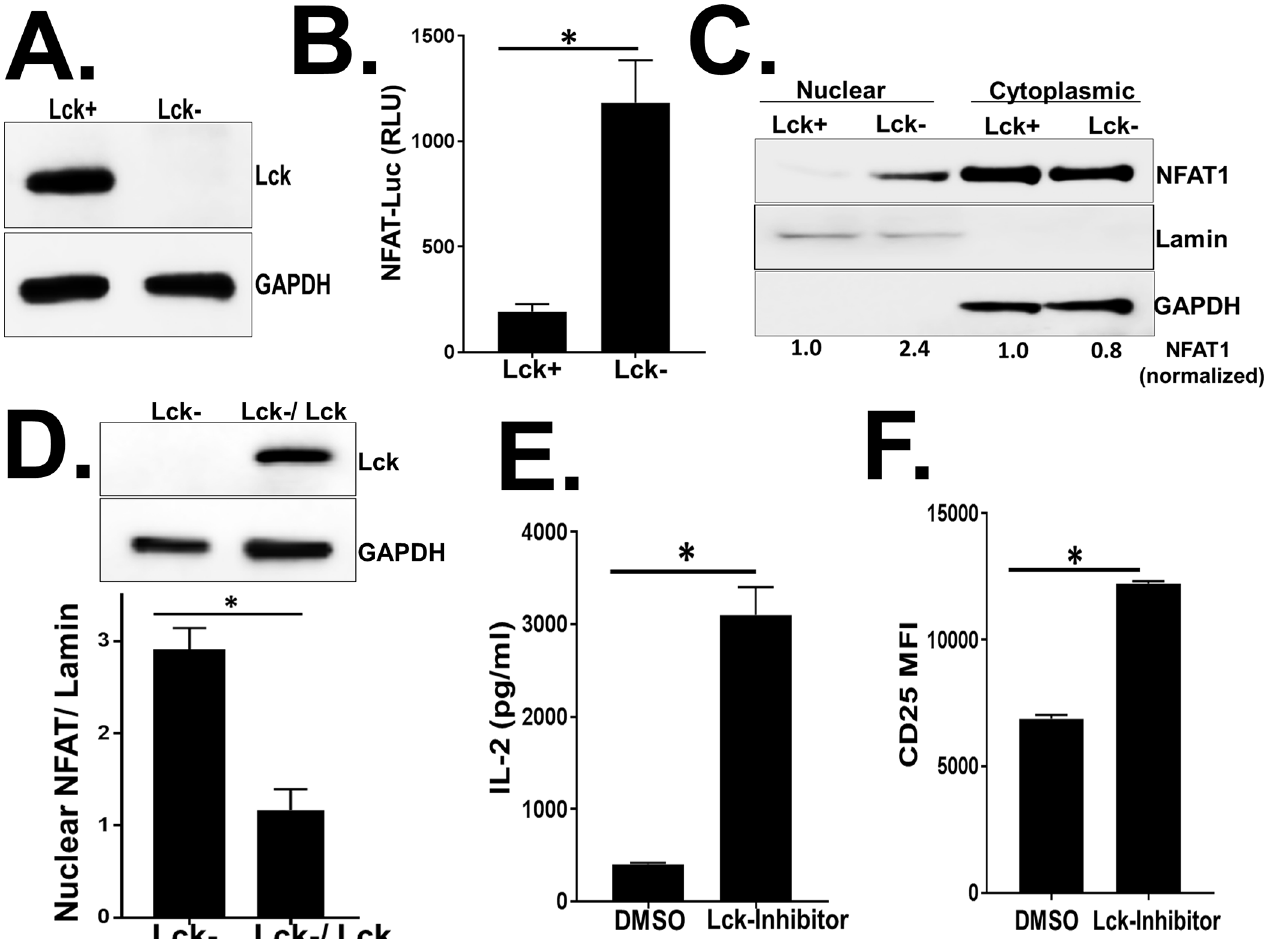
Fig 4. Src-kinase Lck prevents aberrant NFAT1 activation in unstimulated Jurkat T cells. (A) Immunoblotanalysisof Lck expressionin Jurkat T cells either expressing(Lck+) or not expressing(Lck-) Src-kinase Lck. GAPDH served as a loadingcontrol. (B) NFAT1-dependentfirefly luciferaseactivity (NFAT1-Luc) was measuredin Lck+ or Lck- Jurkat T cells. Firefly luciferase activity was normalizedto renillaluciferase activity. (C) Immunoblotanalysisof subcellular localization of NFAT1, GAPDH and Lamin in Lck+ or Lck- Jurkat T cells. GAPDH and Lamin served as a loadingcontrol for cytoplasmic and nuclear fractions respectively.NFAT1 protein levels in the cytoplasmic fraction and nuclear fractions were normalized with GAPDH and Lamin protein levels respectively.(D) Immunoblot analysisof NFAT in nuclear fraction obtainedfrom Lck-deficient (Lck-) and Lck expressionrescued(Lck-/Lck) Jurkat T cells. Activation of distal TCR signalingwas measuredby assessing (E) IL-2 release and (F) CD25 surface expressionin Lck+ Jurkat T cells followingtreatment with DMSO or Lck-specificinhibitor(Lck inhibitorII) and PMA/Ionomycin stimulation.RLU = relative luciferase units. Data represent the averageof three technical replicates, and the standard deviationis shown. Each experiment was independently performed three times with similar results. * P < 0.01.